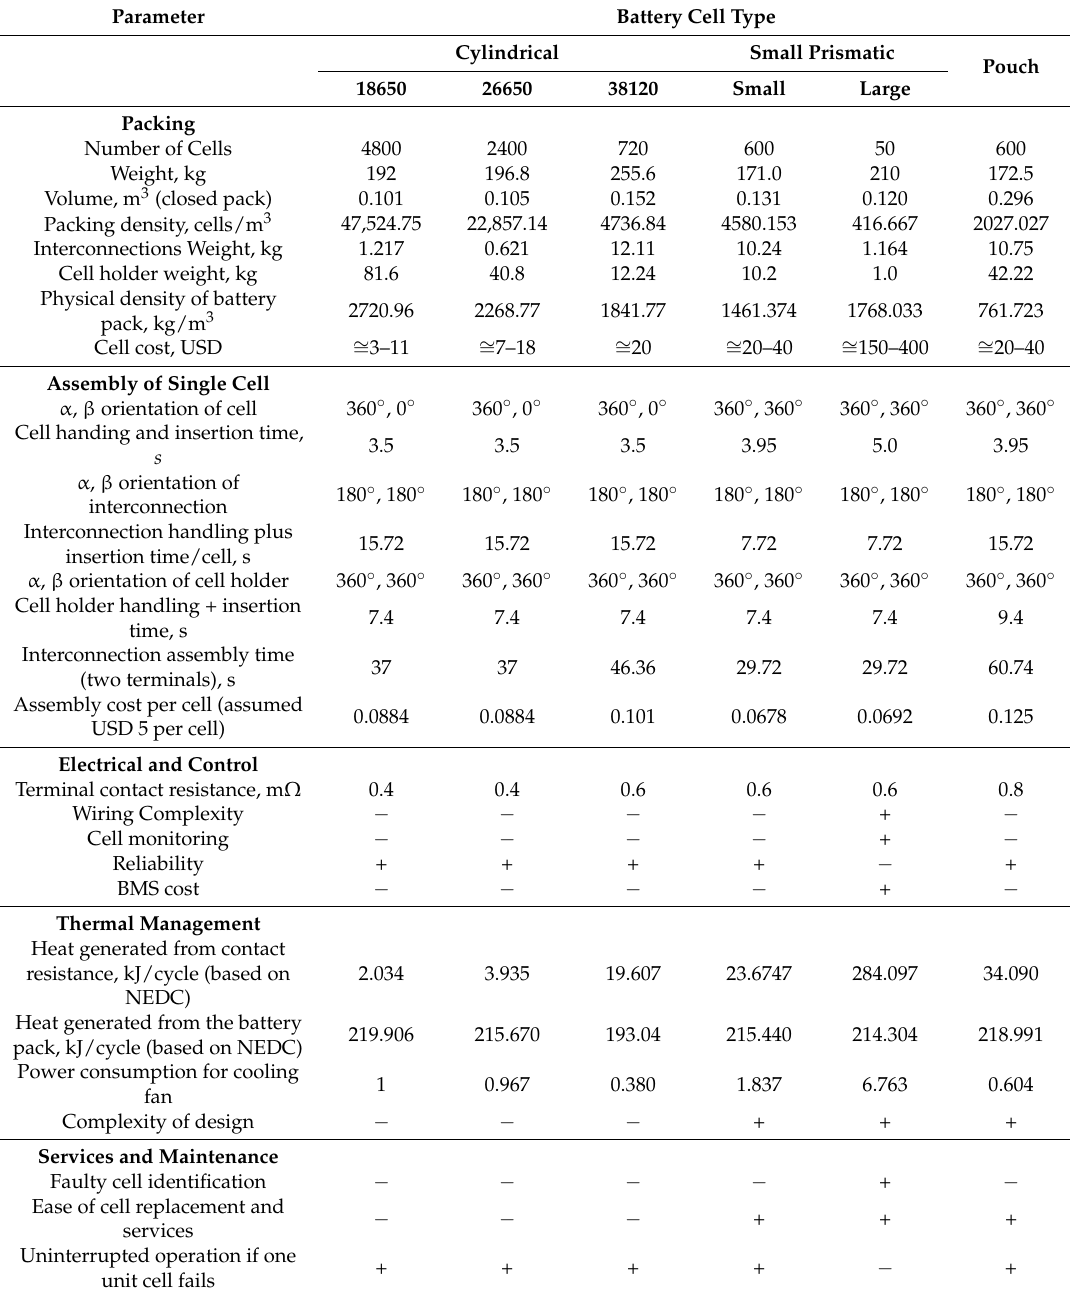
Table 5. Comparison of different design characteristics of 19.2 kWh LiFePO 4 battery pack formed by using different types of battery cells